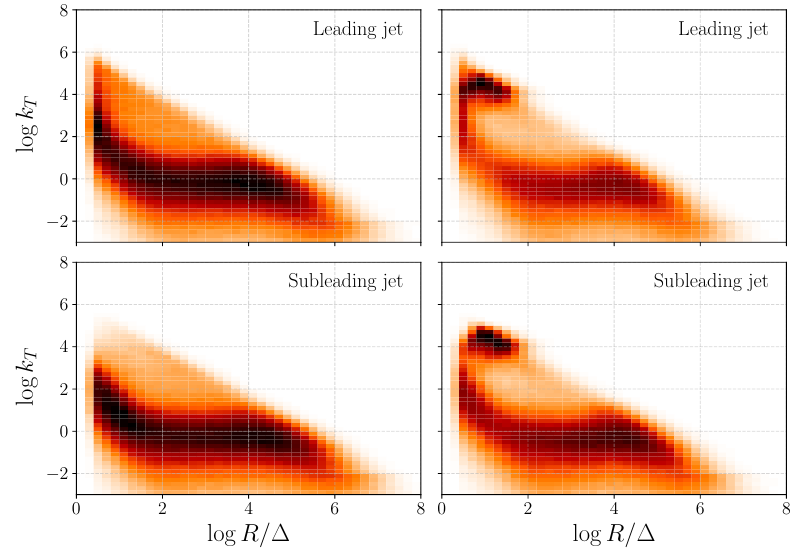
Figure 6 . Distributions of QCD (left) and t (cid:22) t (right) di-jet events in the (log k See text for